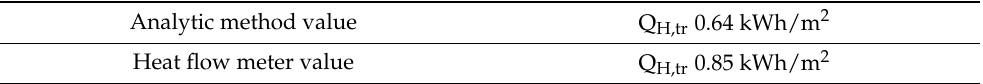
Table 11. Ante operam energy losses by transmission through wall (Q H,tr